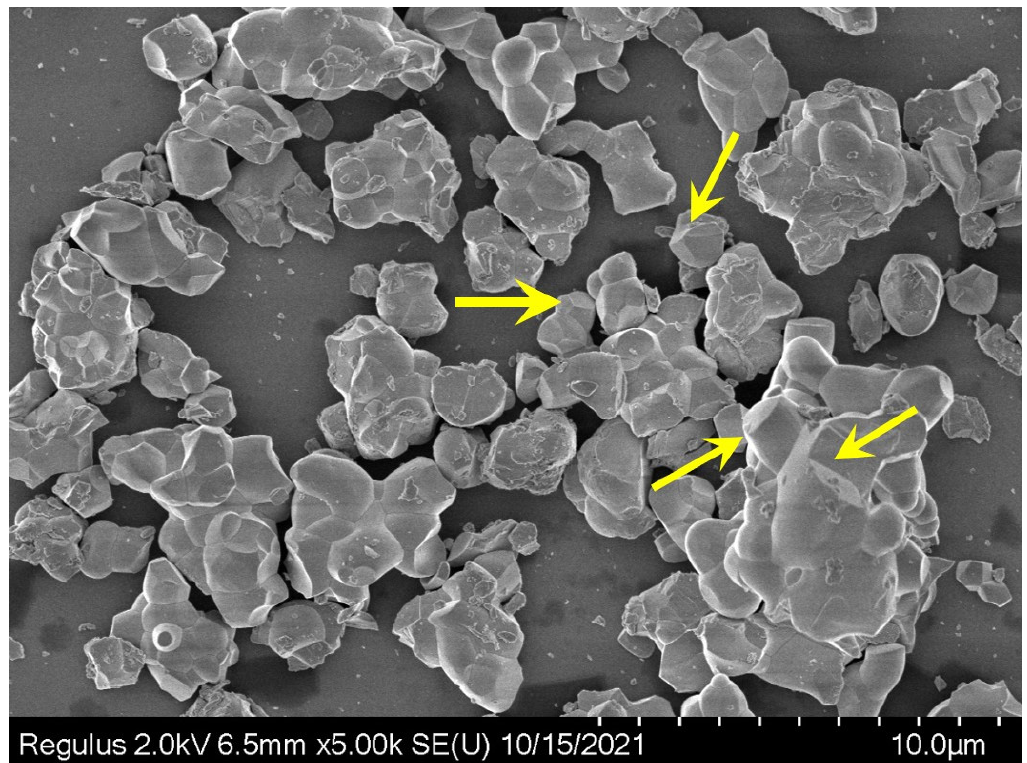
Figure 2. The SEM picture of the CeSc 3 (BO 3 ) 4 :Cr 3+ phosphor particles. The emission and excitation spectra of RESc 3 (BO 3 ) 4 :Cr 3+ (RE = Ce, Gd, Tb, Lu) dis- played in Figure 3 show that the luminescence intensity of CeSc 3 (BO 3 ) 4 :Cr 3+ is nearly four times higher than that of LuSc 3 (BO 3 ) 4 :Cr 3+ and more than 10 times higher than that of GdSc 3 (BO 3 ) 4 :Cr 3+ and TbSc 3 (BO 3 ) 4 :Cr 3+ . This phenomenon is very interesting. The meas- ured quantum yield and absorbance of CeSc 3 (BO 3 ) 4 :Cr 3+ are 65.8% and 24.4%, respectively.